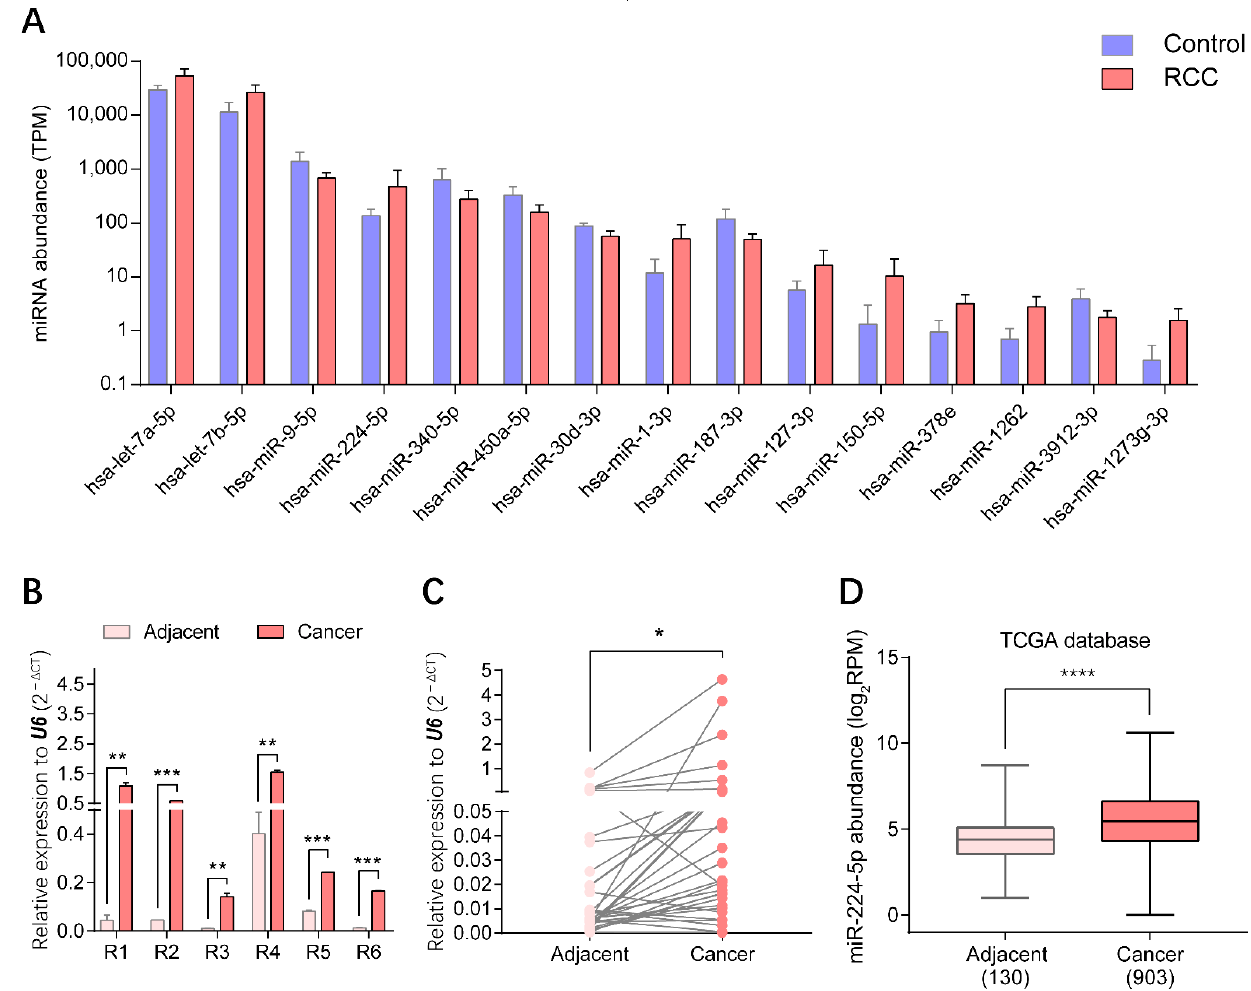
Figure 3. miR-224-5p was overexpressed in both urinary EVs and cancer tissues of RCC patients. ( A ) Top 15 significantly expressed miRNAs in urinary EVs from RCC patients and healthy volunteers ( p < 0.01). ( B ) miR-224-5p levels in cancer and adjacent tissues of RCC samples used in small RNA-sequencing were determined by RT-qPCR. Data are mean ± s.e.m. ( C ) miR-224-5p expression levels in paired-tissues of RCC patients were determined by RT-qPCR (n = 35). ( D ) miR-224-5p expression levels in TCGA database (n = 130 for adjacent group; n = 903 for cancer group). * p < 0.05; ** p < 0.01; *** p < 0.001; **** p <